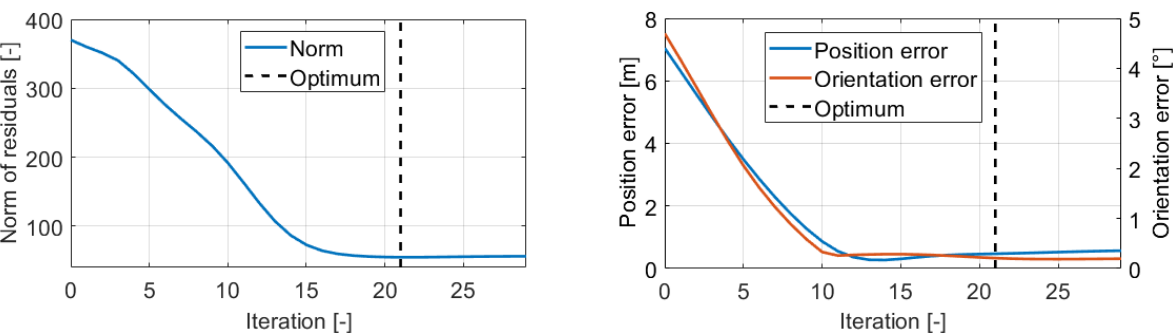
Figure 19. Estimation errors.